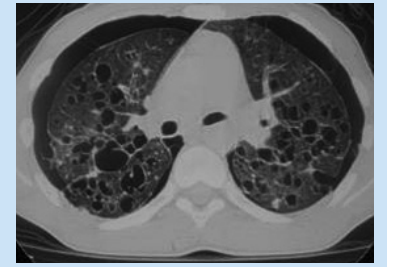
Fig. 18. Langerhans cell histiocytosis with bilateral pneumothoraces.